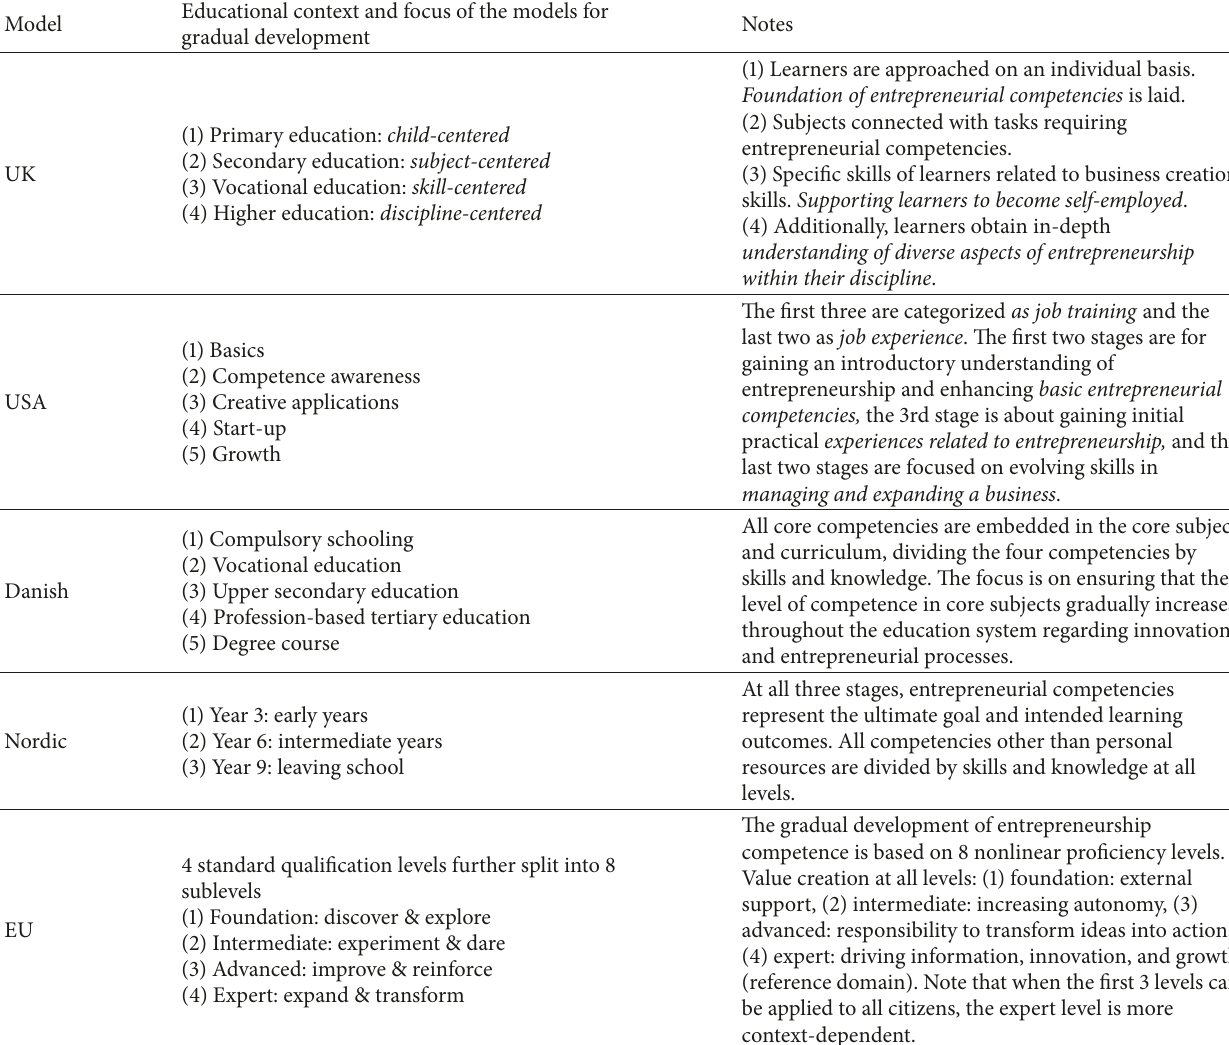
Table 2: Description of when and/or how expected competence levels advance in the EE competence models.